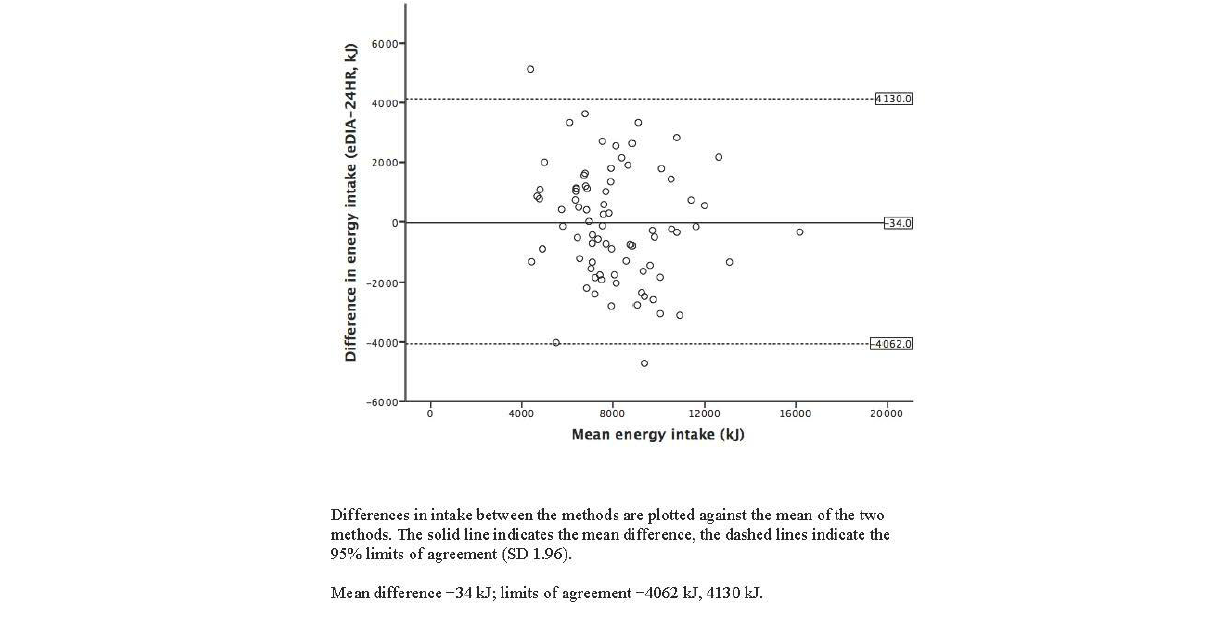
Figure 3. Bland-Altman plot of 24-hour dietary recalls (24HR) and electronic Dietary Intake Assessment (e-DIA) for energy intake.